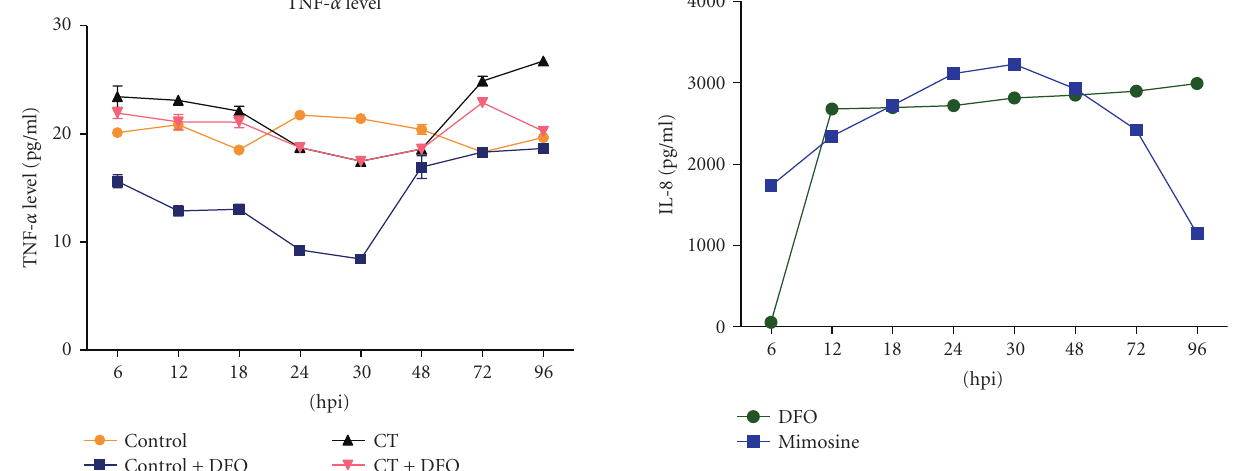
Figure 2: TNF- α concentration as determined by ELISA in C. trachomatis infected culture supernatant was significantly ( P < 0 . 001) increased at early time points (6, 12, and 18hpi) and late time points (72 and 96 hpi), whereas there was decrease at midtime points (24, 30 and 48hpi) in comparison to mock infected.